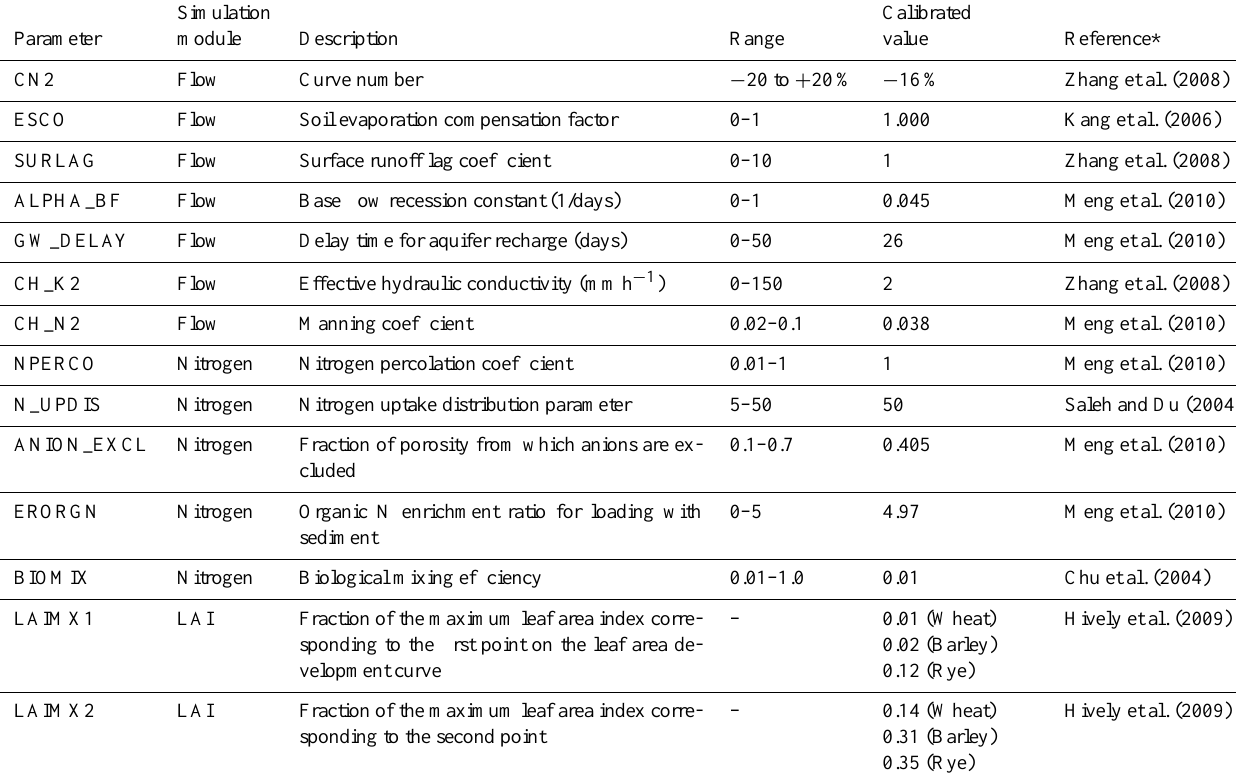
Table 2. List of calibrated